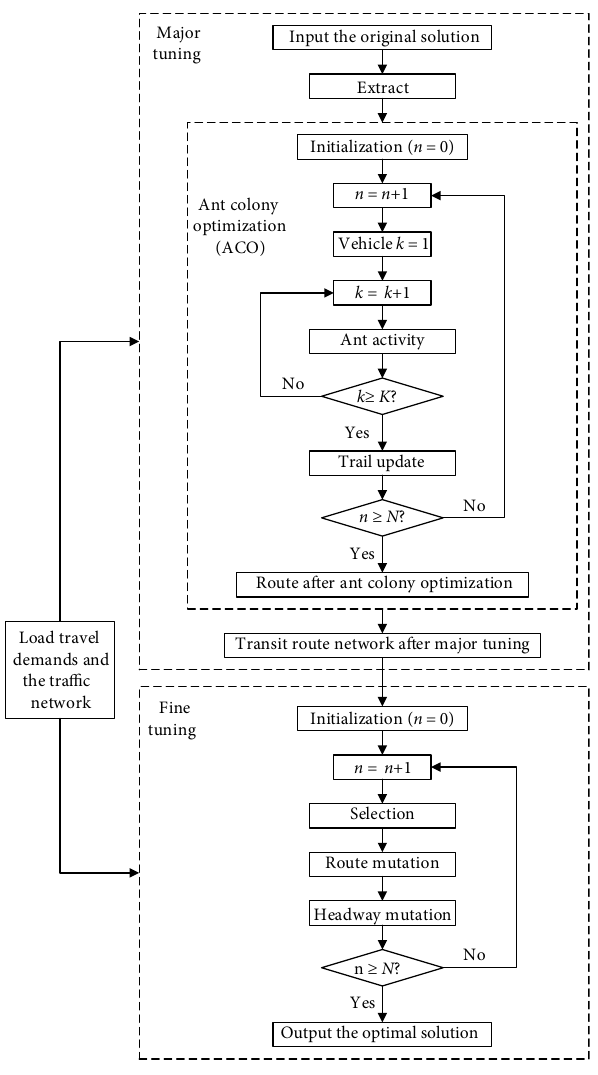
Figure 1: Flowchart of the